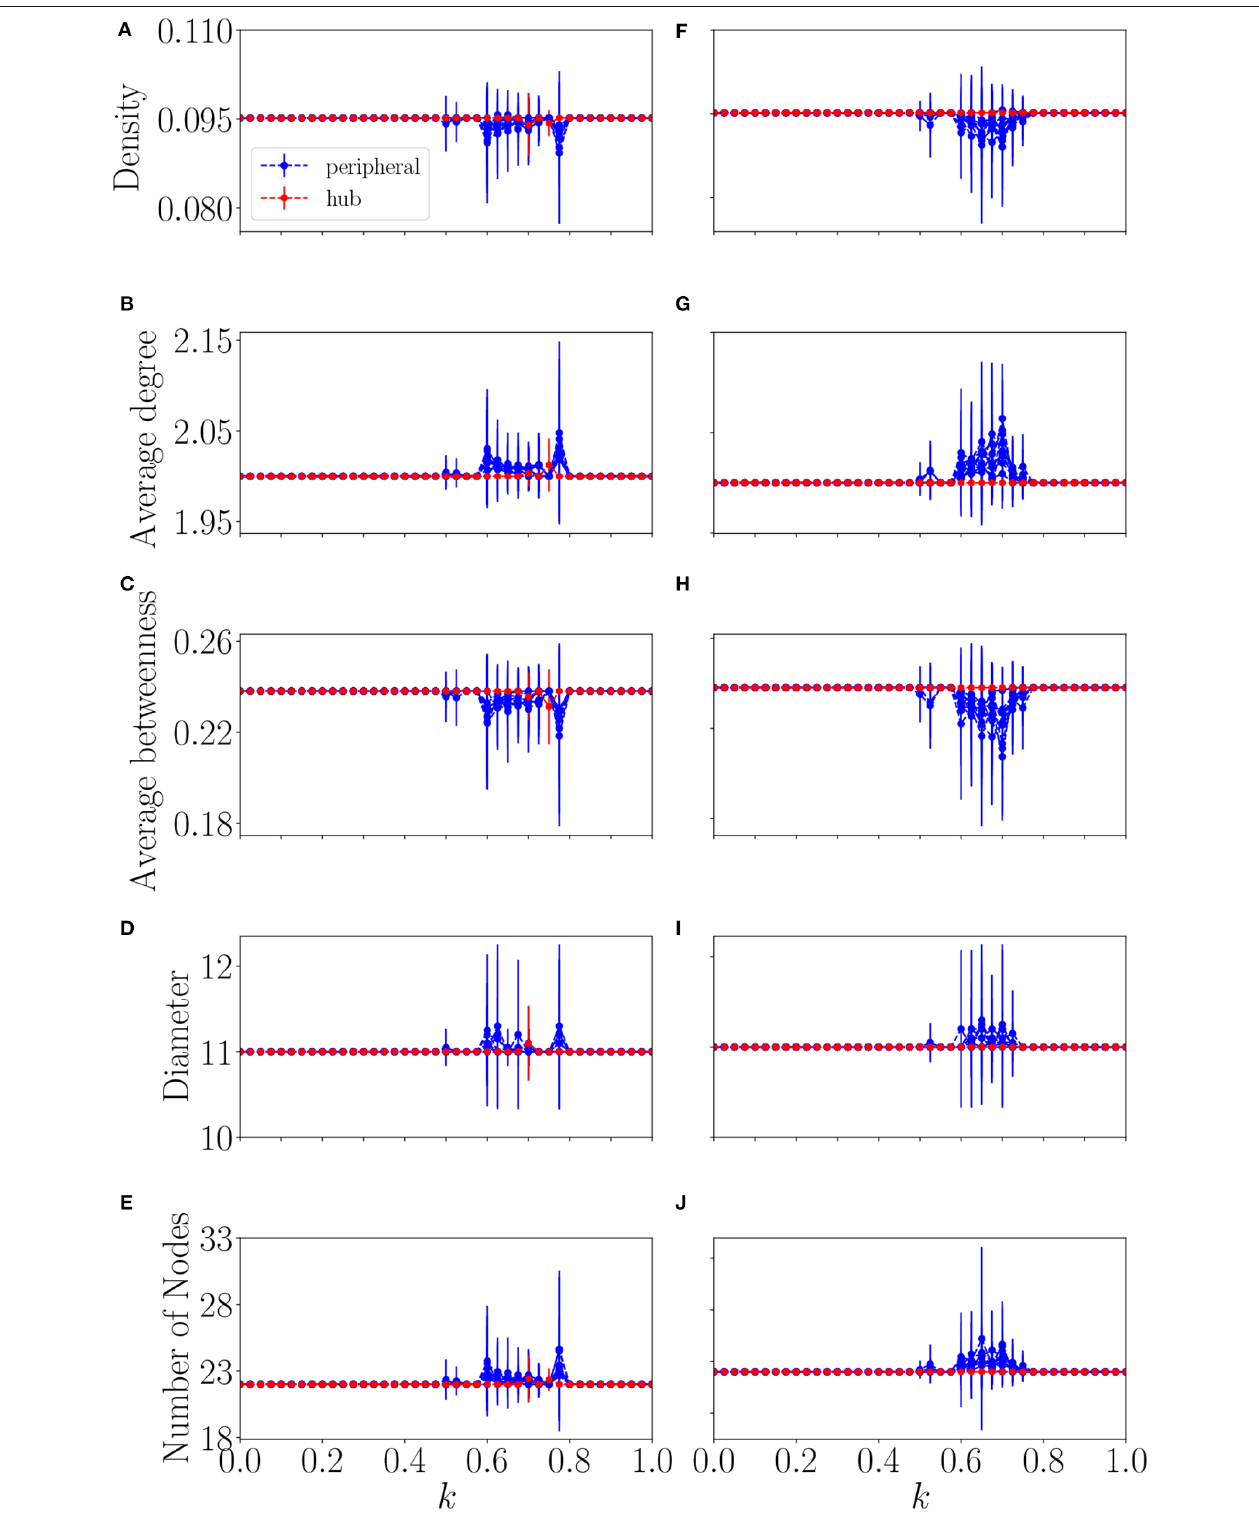
FIGURE 8 | Network 2. Mean and standard deviation of the network metrics (A,F) density, (B,G) average degree, (C,H) average betweenness, (D,I) diameter, and (E,J) average number of nodes as a function of coupling k . The plots on the left refer to Star 1, the plots of the right column refer to the Star 2. Values of metrics related to the peripheral nodes are in blue and related to the hub are in